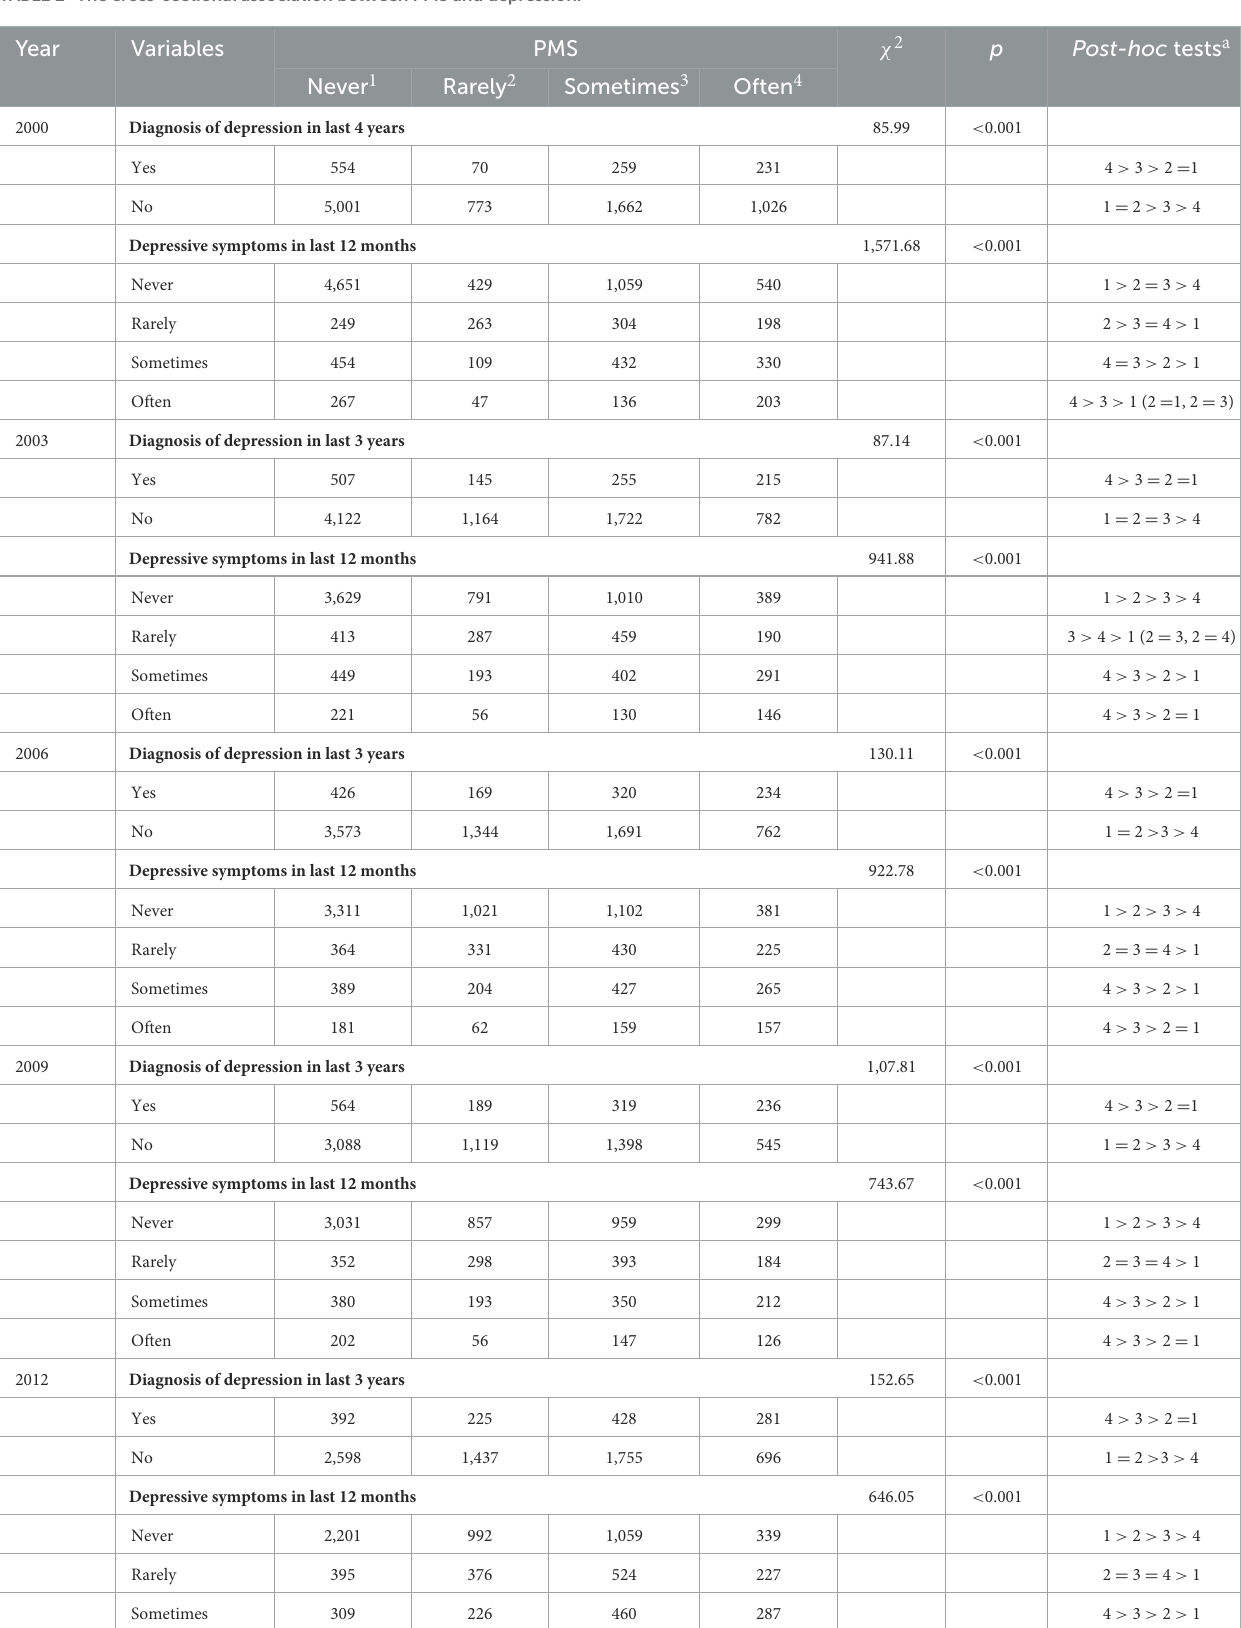
TABLE 2 The cross-sectional association between PMS and